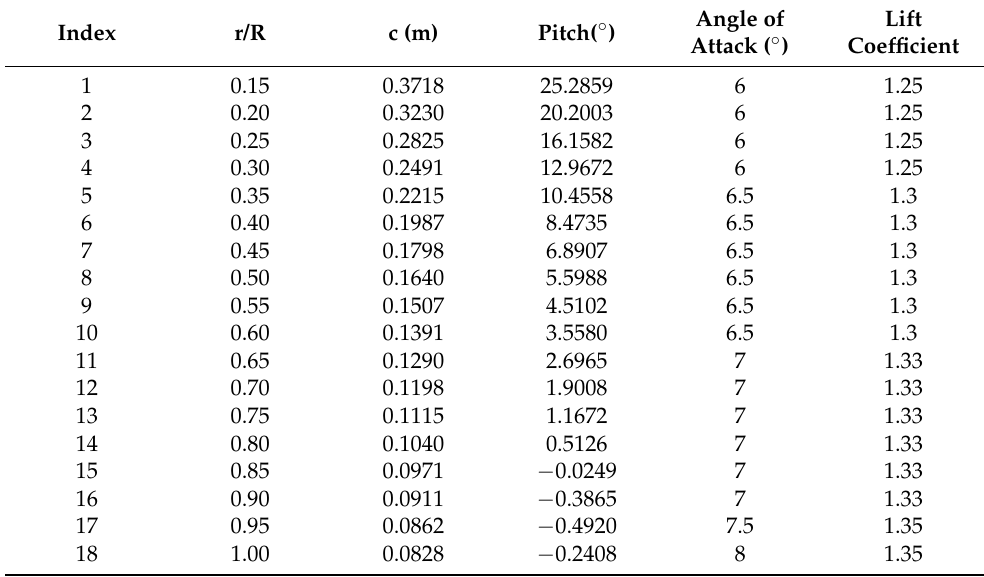
Table 2. Blade element data at different blade